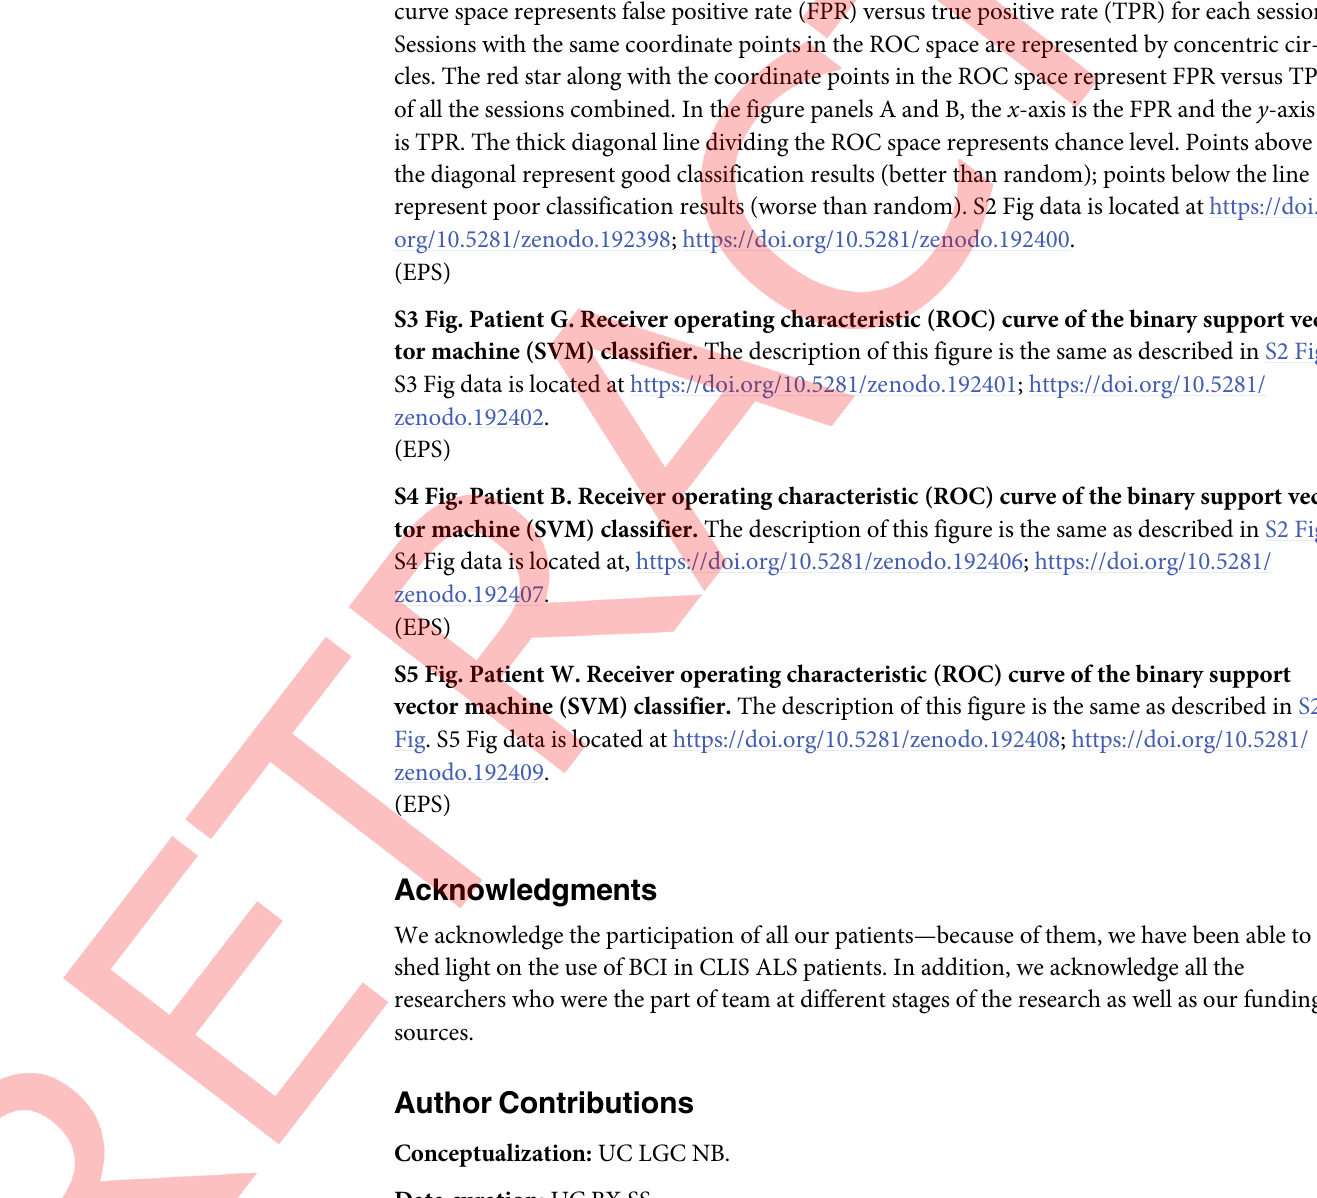
S2 Fig. Patient F. Receiver operating characteristic (ROC) curve of the binary support vec- tor machine (SVM) classifier. (A) Training and (B) feedback sessions. Each circle in the ROC curve space represents false positive rate (FPR) versus true positive rate (TPR) for each session. Sessions with the same coordinate points in the ROC space are represented by concentric cir- cles. The red star along with the coordinate points in the ROC space represent FPR versus TPR of all the sessions combined. In the figure panels A and B, the x -axis is the FPR and the y -axis is TPR. The thick diagonal line dividing the ROC space represents chance level. Points above the diagonal represent good classification results (better than random); points below the line represent poor classification results (worse than random). S2 Fig data is located at https://doi.